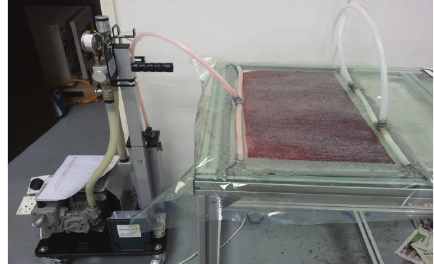
Figure 2: The composite specimen using vacuum infusion tech-